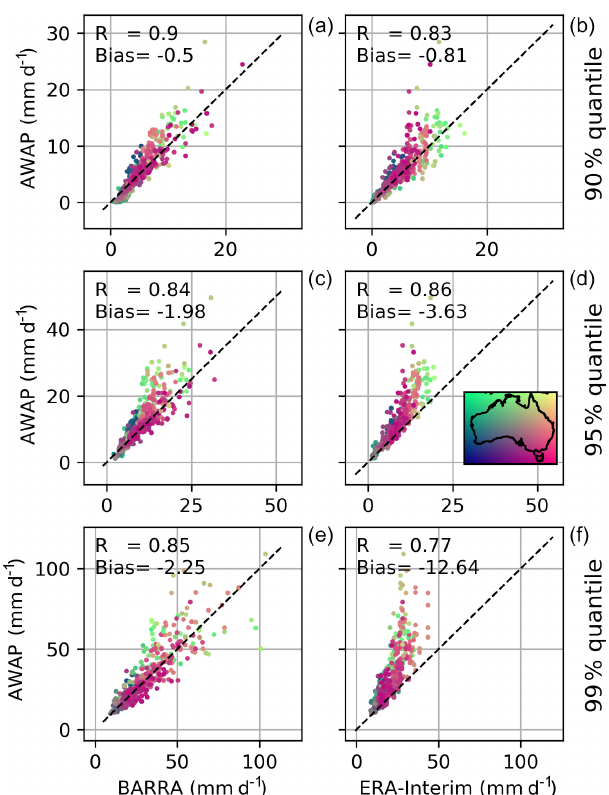
Figure 8. Wet-day frequency estimates from reanalysis datasets (BARRA and ERA-Interim) and AWAP at gauge locations (a, b) . Transition probabilities: dry–wet ( p 01 : c, d ) and wet–wet ( p 11 : e, f ). Colour of scatter indicates the location of the AWAP grid.